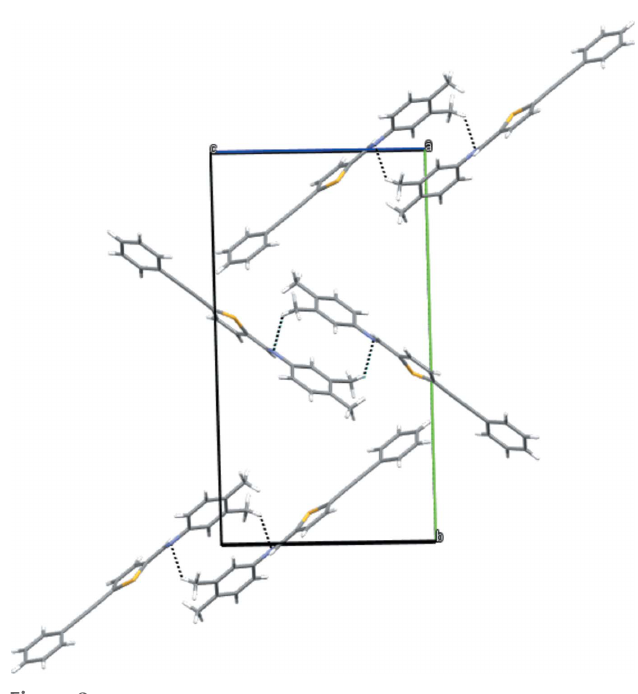
Figure 2 A view along [100] showing short packing contacts between imine N atoms and methyl H atoms on neighboring molecules (Macrae et al. ,